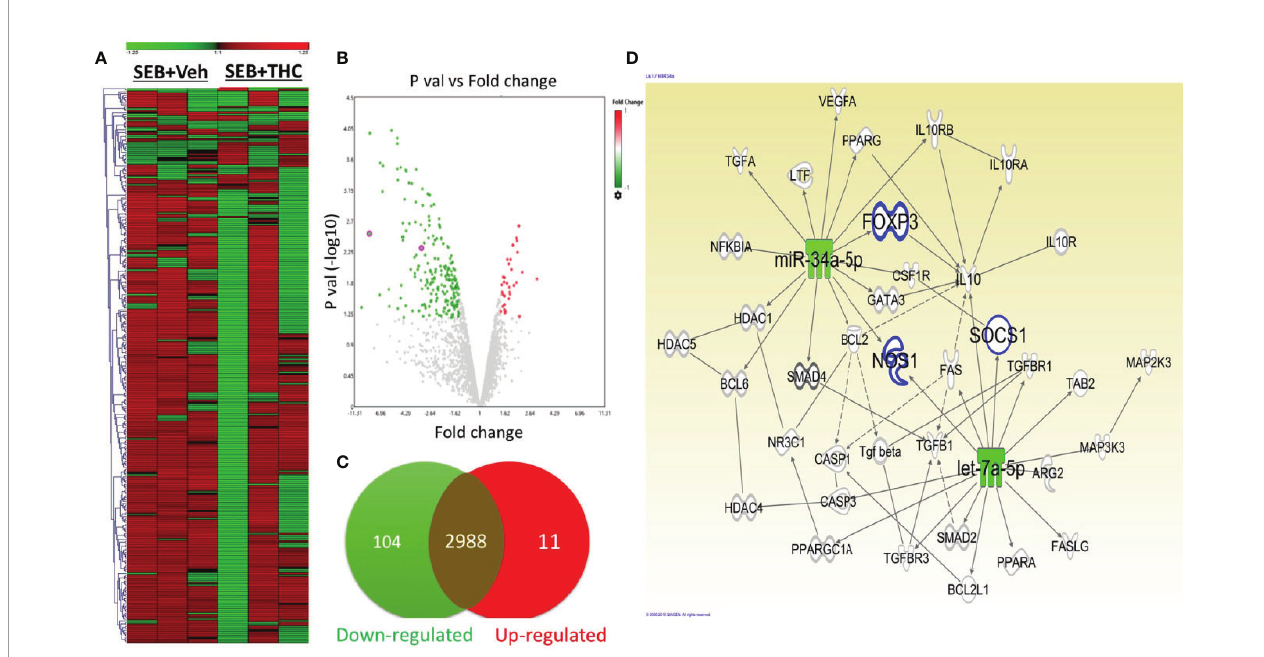
FIGURE 4 | THC alters miR expression in lung in fi ltrated MNCs exposed to SEB. Mice were treated with SEB + Veh or SEB + THC as described in Figure 1 legend. MNCs from the lungs were isolated and screened for miR expression as described in Methods. (A) Heat map of all miRs in SEB + Veh and SEB + THC groups. (B) Volcano plot depicts statistically dysregulated miRNAs in SEB + THC vs. SEB + Veh. (C) Venn diagram of miRs with two-fold change (upregulated, downregulated or no change). (D) Shows pathways and relationship between miRs and genes that regulate Treg, MDSC induction, proliferation, and signaling post- IPA analysis of dysregulated miRs.